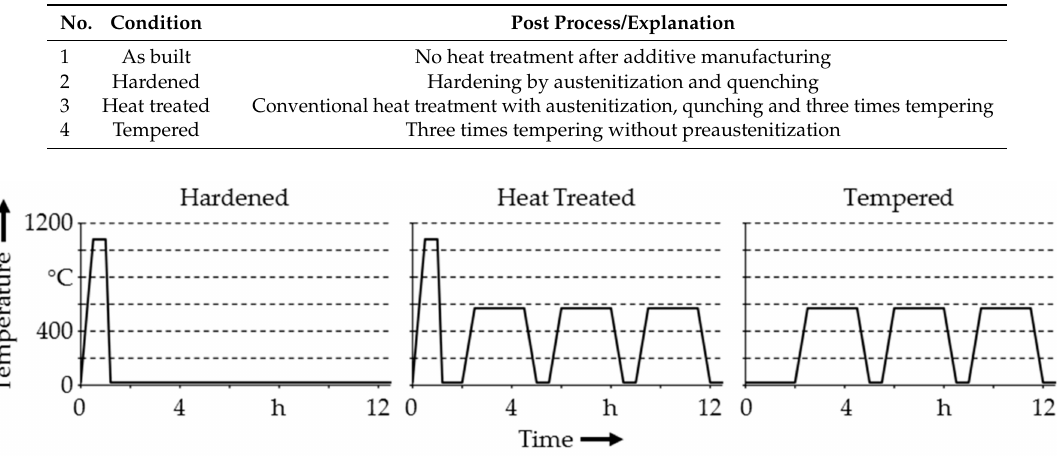
Table 1. Experimental plan for the investigations of additive manufactured specimens.